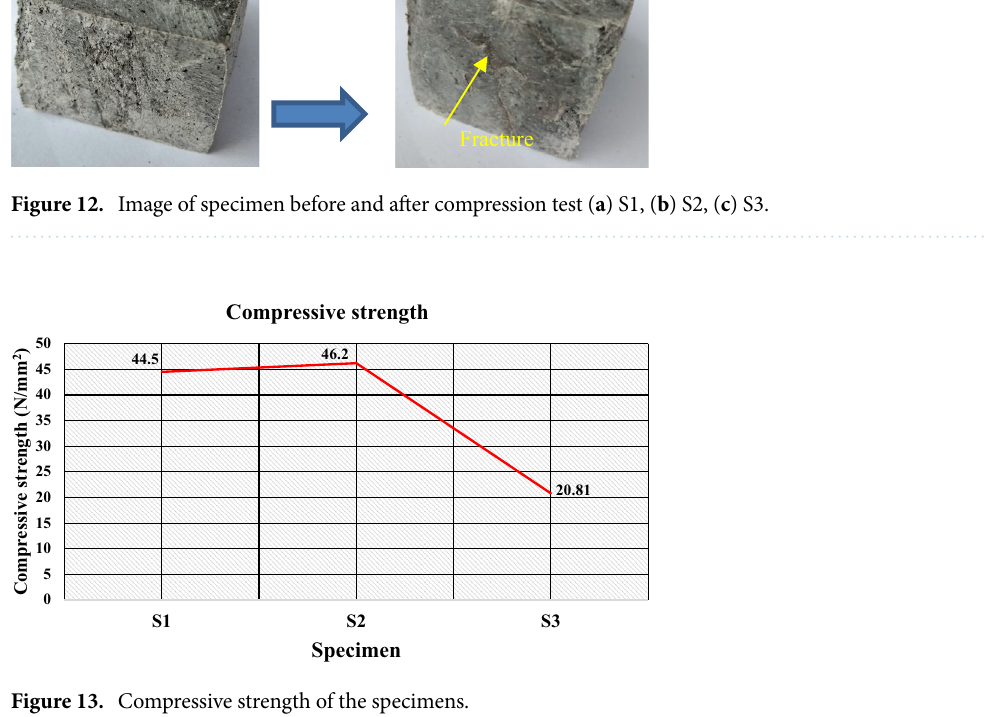
Figure 13. Compressive strength of the